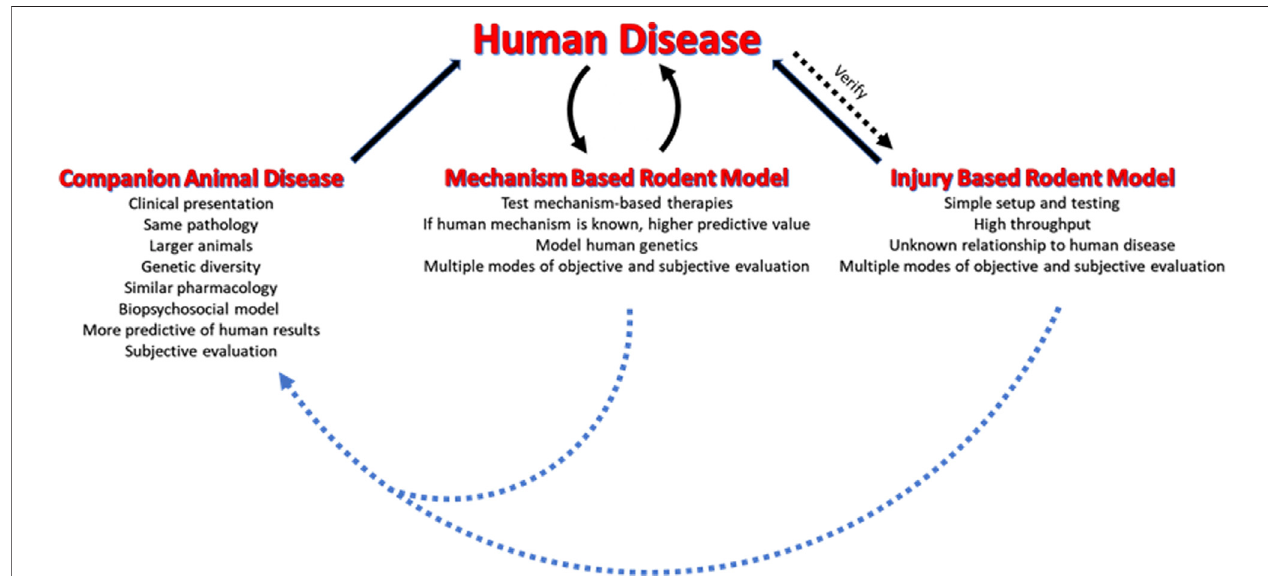
FIGURE1| Modelinghumanpaindisordersinanimals.Rodentinjurymodelshavebeenthestandardforpainresearchandtherapyevaluation.Thesemodelsneed tobe compared tothe humandiseasethey model toensure thatthey arepredictive.Themechanismbasedrodentmodelsare theoreticallysuperior totheinjurymodels duetotheirfocusonspeci fi cmechanismsforproducingpain.Thesemodelsaredevelopedbasedonknownorsuspectedcausesofthehumandisease.Thecompanion animal models are most closely related to human disease and can bridge the gap between rodent studies and humans. If possible, it is recommended that companion animal clinical trials be conducted after the rodent studies and prior to initiating human trials.